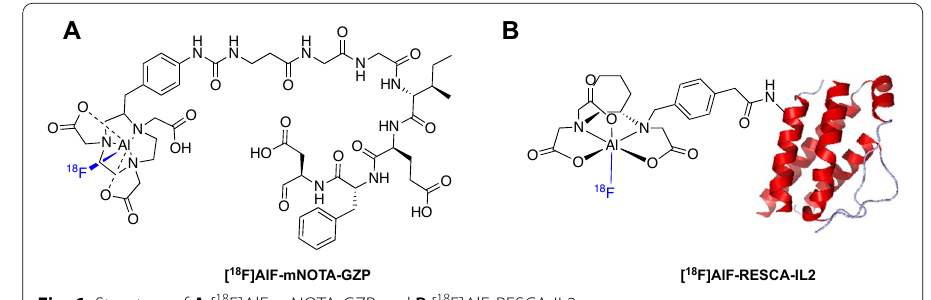
Fig. 6 Structure of A [ 18 F]AlF-mNOTA-GZP and B [ 18